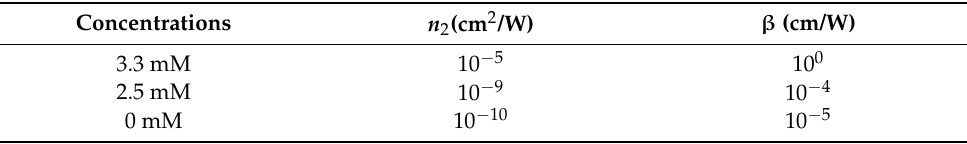
( b ) Figure 13. Nonlinear coefficient as a function of incident angle and gain medium concentration (3.3 mM). ( a ) Nonlinear refraction index 𝑛 2 . ( b ) Nonlinear absorption coefficient β. Table 2. Comparisons of the third-order nonlinear optical coefficients of different doping concen- trations. Concentrations